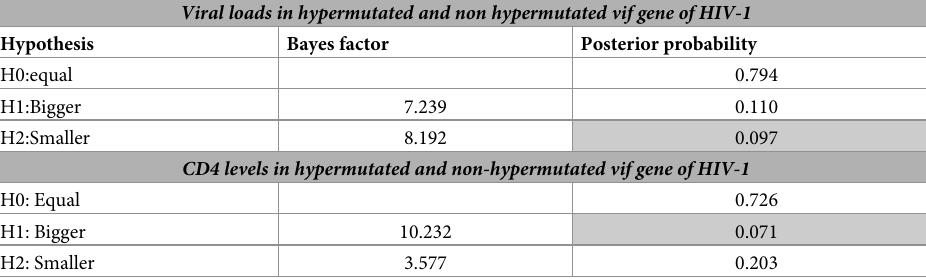
Table 1. Hypermutation in vif gene and clinical parameters of HIV-1 infected patients. Viral loads in hypermutated and non hypermutated vif gene of HIV-1 Hypothesis Bayes